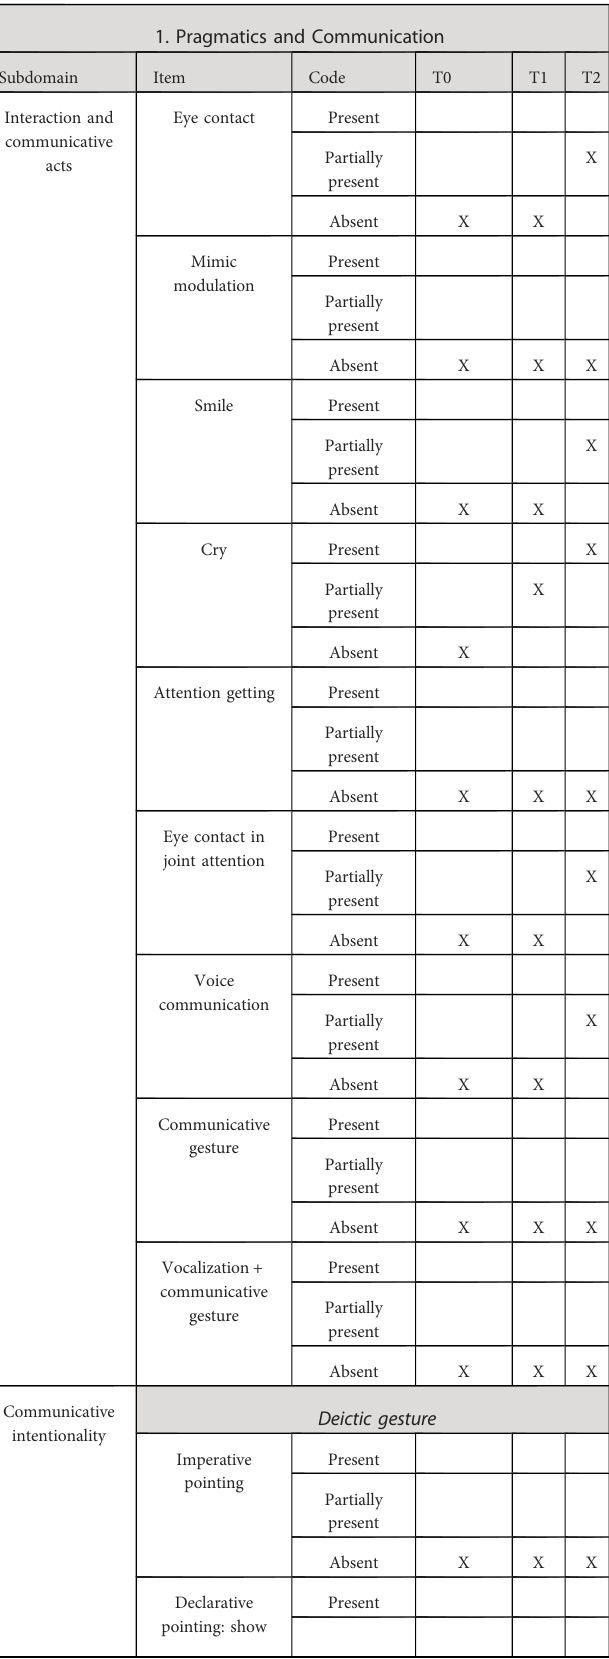
TABLE 3 Case #2 OPISCoS form: effects of the intervention at preintervention (T0), immediate postintervention assessment (T1), and follow-up after 3 months